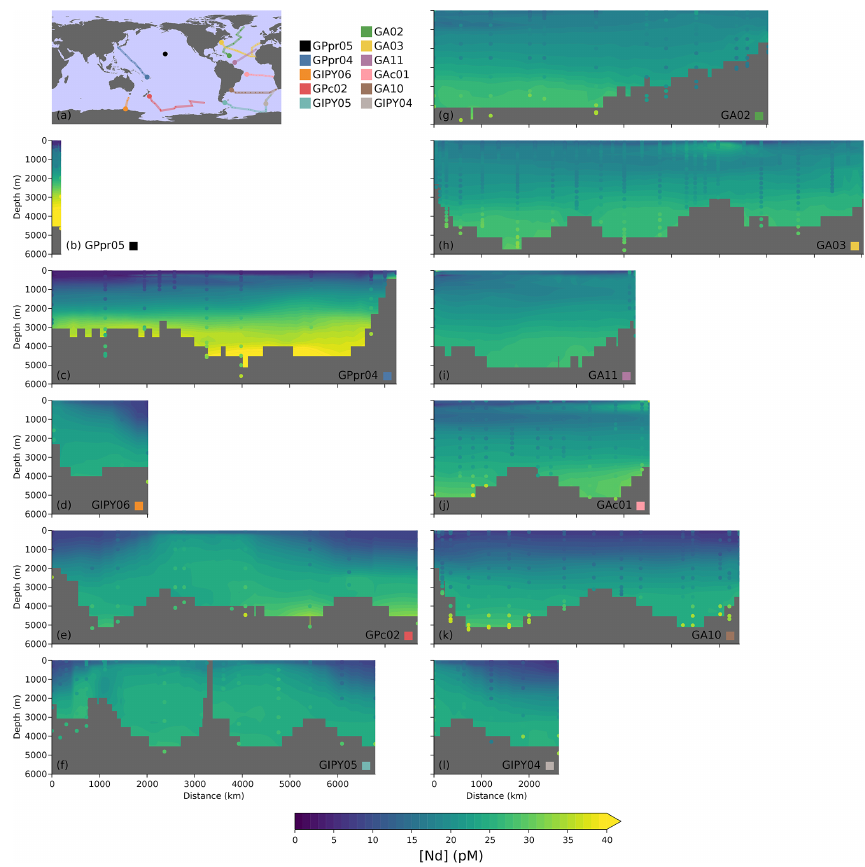
Figure 9. (a) GEOTRACES cruise tracks with [Nd] observations. The legend layout matches the layout of the other subplots of the figure. (b–l) Modeled and observed [Nd] along GEOTRACES transects. Modeled values are shown as filled contours, while observed values are overlaid as a